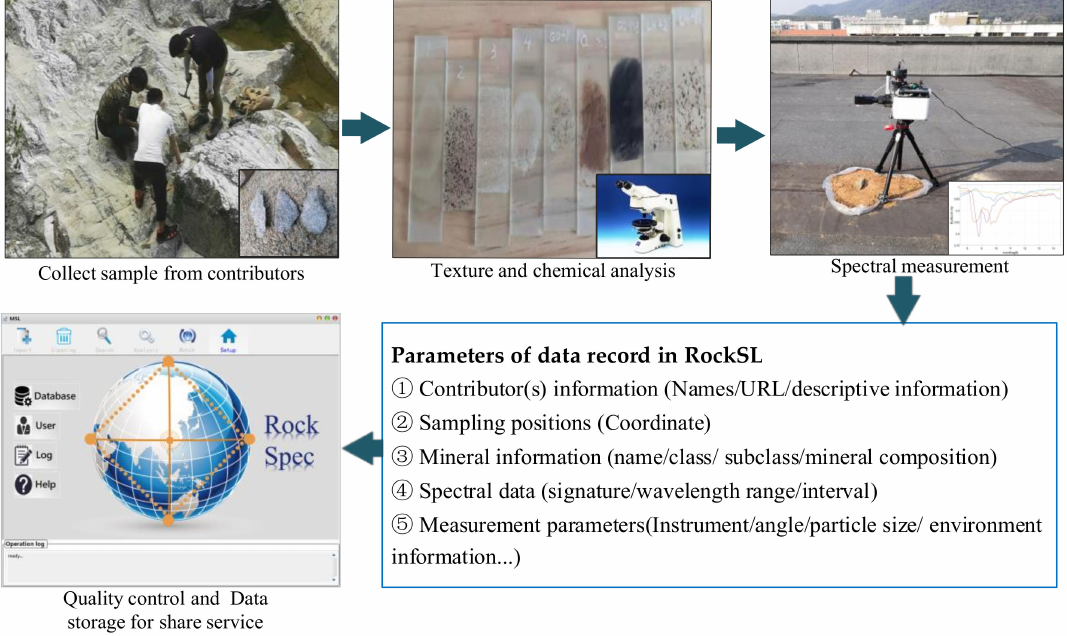
Figure 3. Methodological sequence for the development of the Rock Spectral Library (RockSL) using sampling data and the requirement of contribution data.